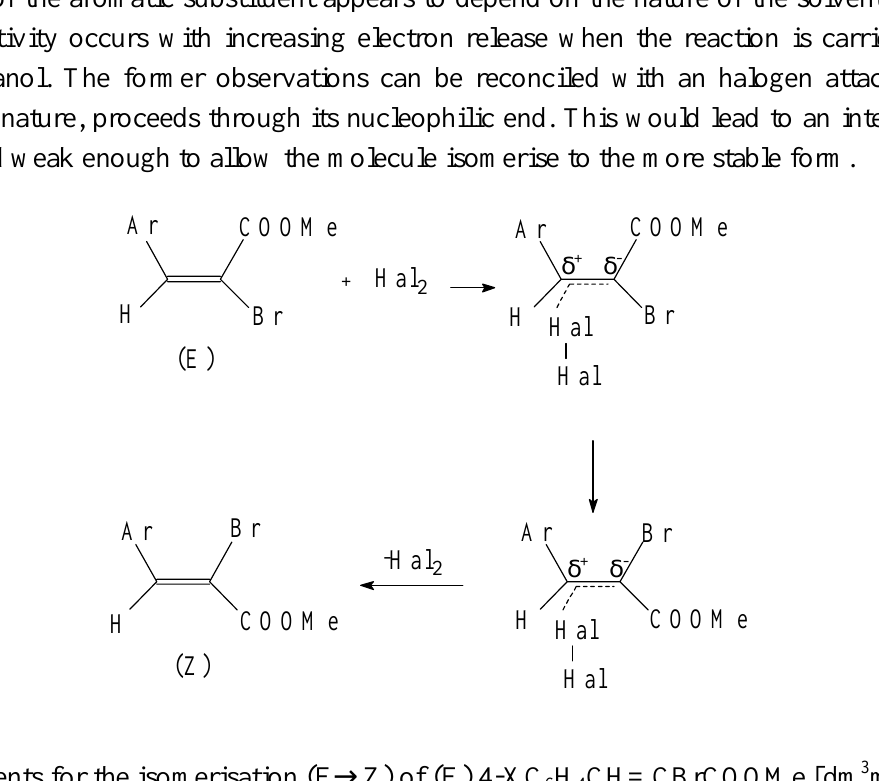
Table . Rate coefficients for the isomerisation (E